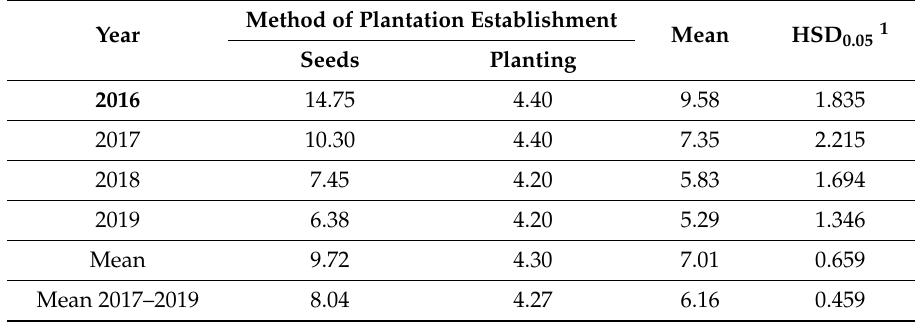
Table 3. Plant number of Silphium per 1 m 2 , depending on methods of plantation establishment. Method of Plantation Establishment Mean HSD 0.05 1 Year Seeds